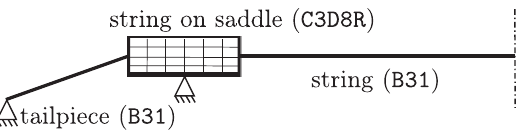
Figure 7. Schematical visualization of the half-string FE model including the coupling between beam and volume